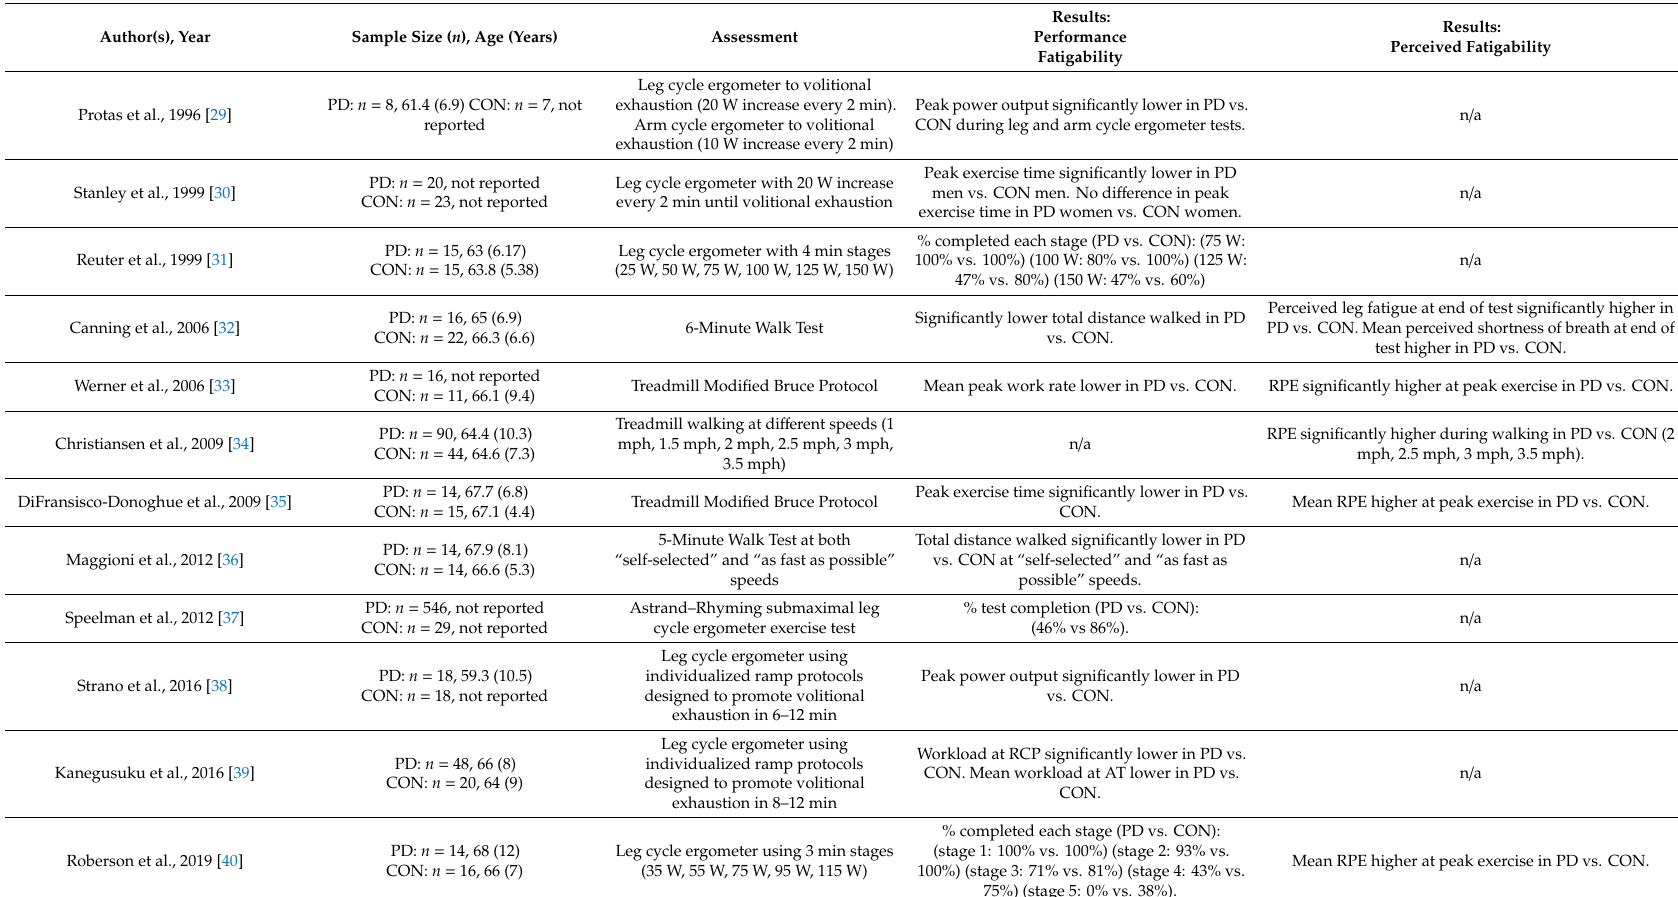
Table 1 Search Strategy: relevant studies were retrieved through PubMed and Google Scholar databases using search terms “Parkinson”, “exercise”, “walking”, cardiopulmonary”, “cardiovascular”, and “treadmill” with no publication date restrictions applied. The reference lists of identified articles were also searched. Only cross-sectional studies with comparisons to a healthy referent group were included. Age is presented as mean (SD). Abbreviations: PD—Parkinson’s disease; CON—healthy referent subjects; W—watts; RPE—ratings of perceived exertion; RCP—respiratory compensation point; AT—anaerobic threshold; n / a—not